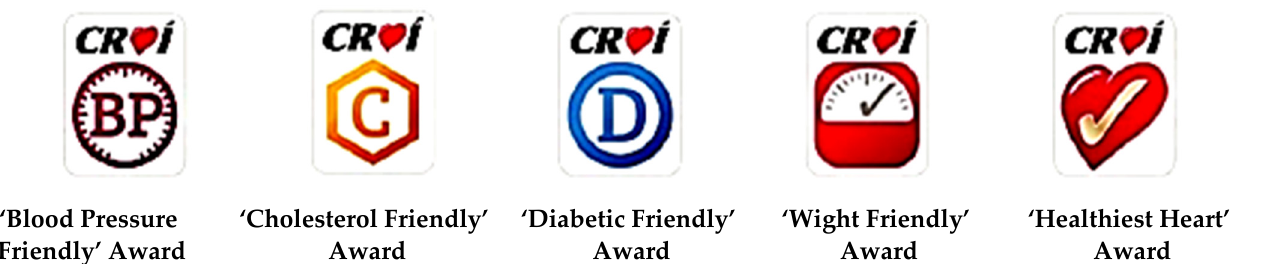
Figure 2. Icon-based menu labels. Source: Kerins et al., [32].